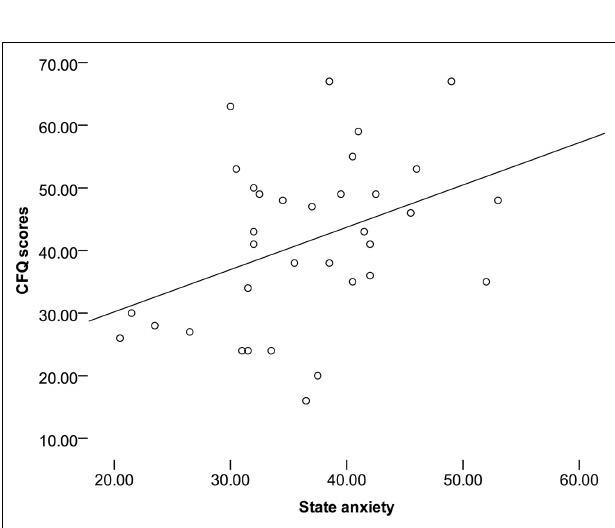
FIGURE 1 | Relationship between CFQ scores and antisaccade latencies (collapsed across load).